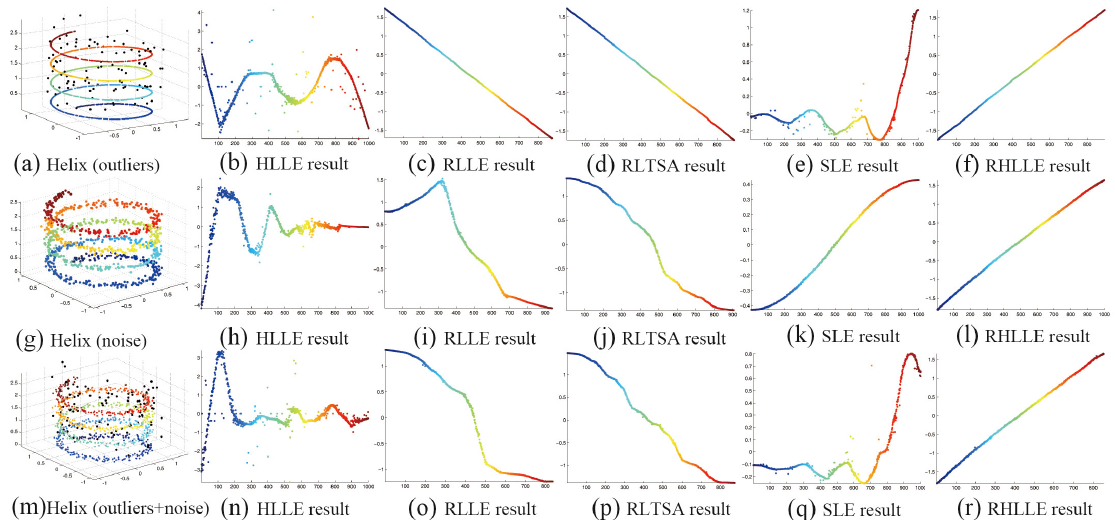
Figure 5. The first row shows the Helix curve dataset with outliers and the embedding results of different algorithms; The second row shows the Helix curve dataset with noise and the embedding results of different algorithms; The third row shows the Helix curve dataset with both outliers and noise and the embedding results of different algorithms.